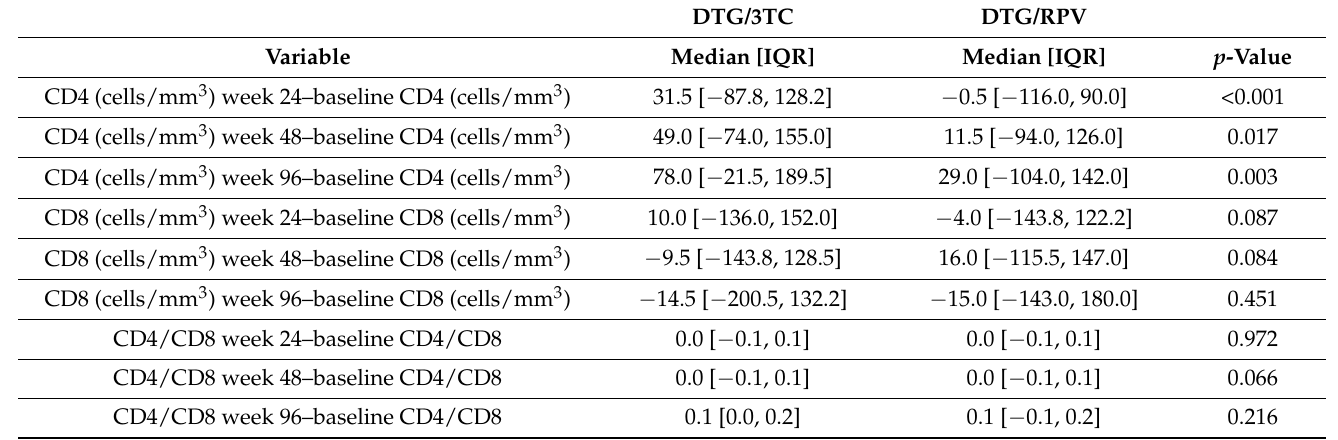
Table A1. Rate of virological suppression at weeks 24, 48, and 96 for the overall population and by